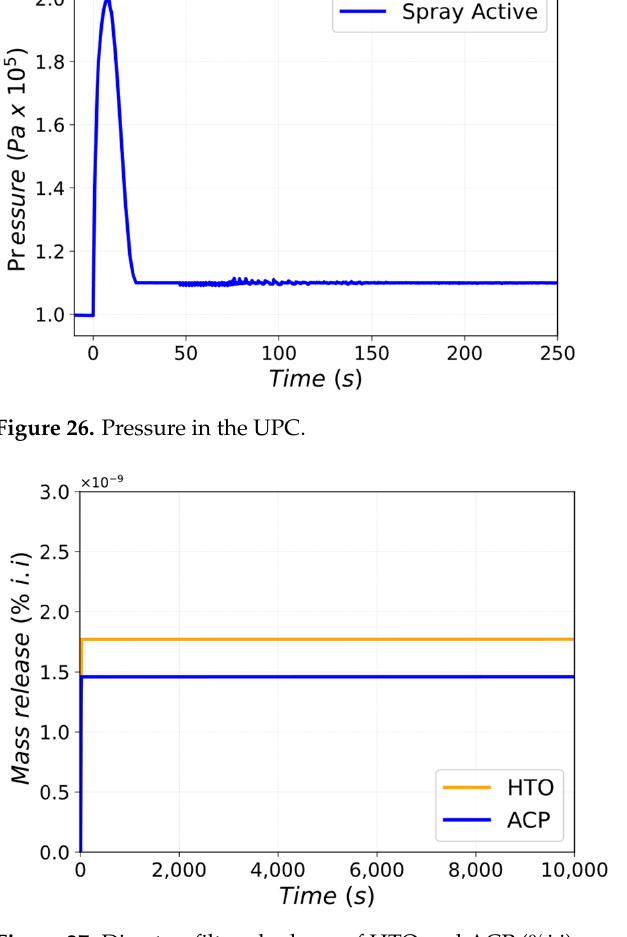
Figure 27. Direct unfiltered release of HTO and ACP (%i.i).